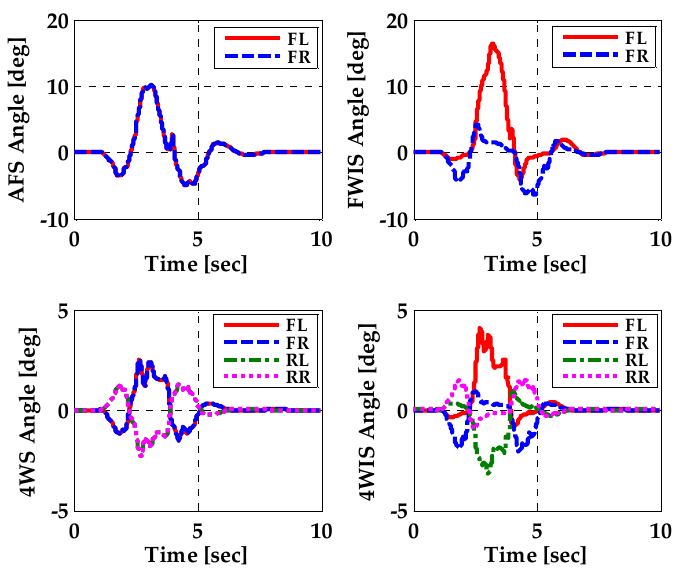
Figure 5. Corrective steering angles of each actuator. Table 2. Maximum absolute yaw rate error for each actuator and method.